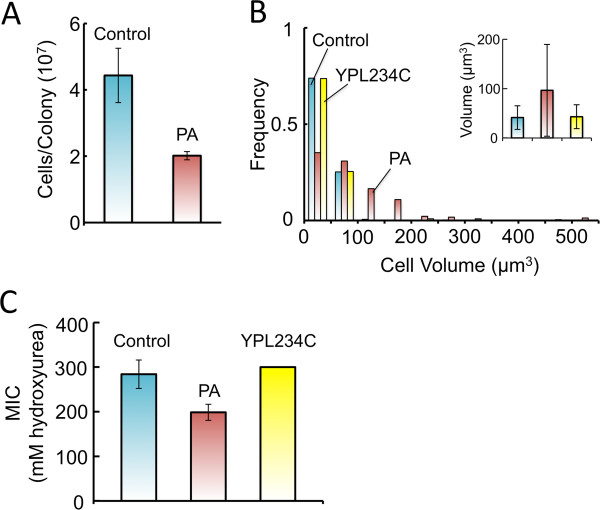
Low-level expression of the PA incompatibility domain results in fewer and larger cells. A) The number of cells in a 1 mm diameter colony was determined by cell counts with a haemocytometer. Significantly fewer cells were present in colonies of PA-expressing strain than the control strain (P = 0.003). Error bars represent standard deviation from 5 biological replicates. B) Volume measurements of cells grown on YPD show that PA-expressing cells were on average significantly larger than those of the control strain and the vacuolar ATPase mutant, YPL234C (P < 0.001, Wilcoxon/Kruskal Wallis test). Volumes were grouped into 50 μm3 bins and plotted. Inset: The average cell volume (±SD) of the three strains with shading as in main figure. C) PA-expressing yeast had increased sensitivity to hydroxyrurea, a potent inhibitor of RNR activity, when compared to the control strain and the vATPase-defective strain YPL234C, as determined through MIC measurements. Error bars represent standard deviation of 5 biological replicates.